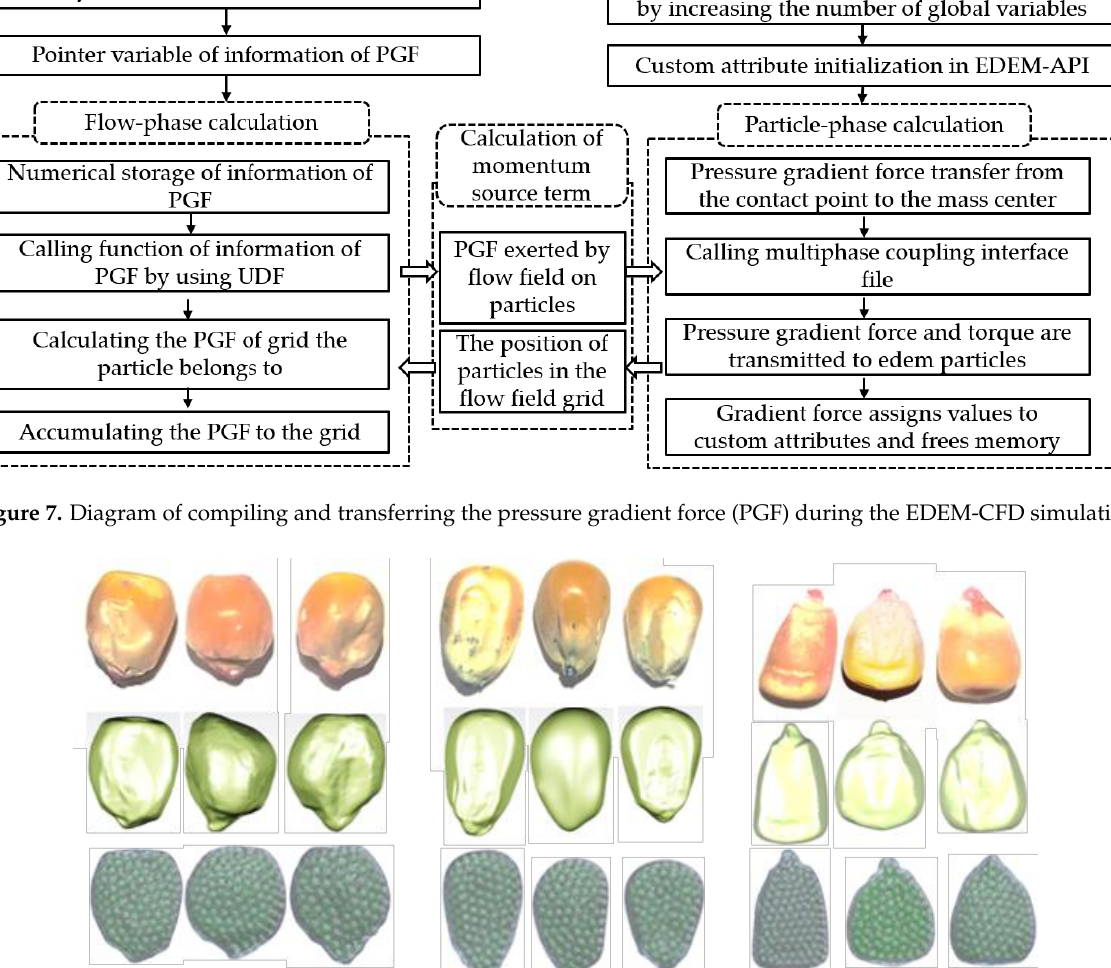
Figure 8. Simulation models of the maize seeds. ( a ) Denghai 605 variety; ( b ) Denghai 615 variety; ( c ) Nonghua 101 variety.